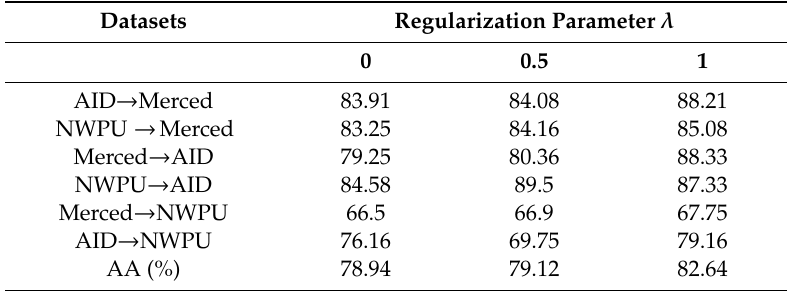
Table 10. Sensitivity analysis with respect to the regularization parameter for the VHR dataset. Results are expressed in terms of OS (%) and AA (%).